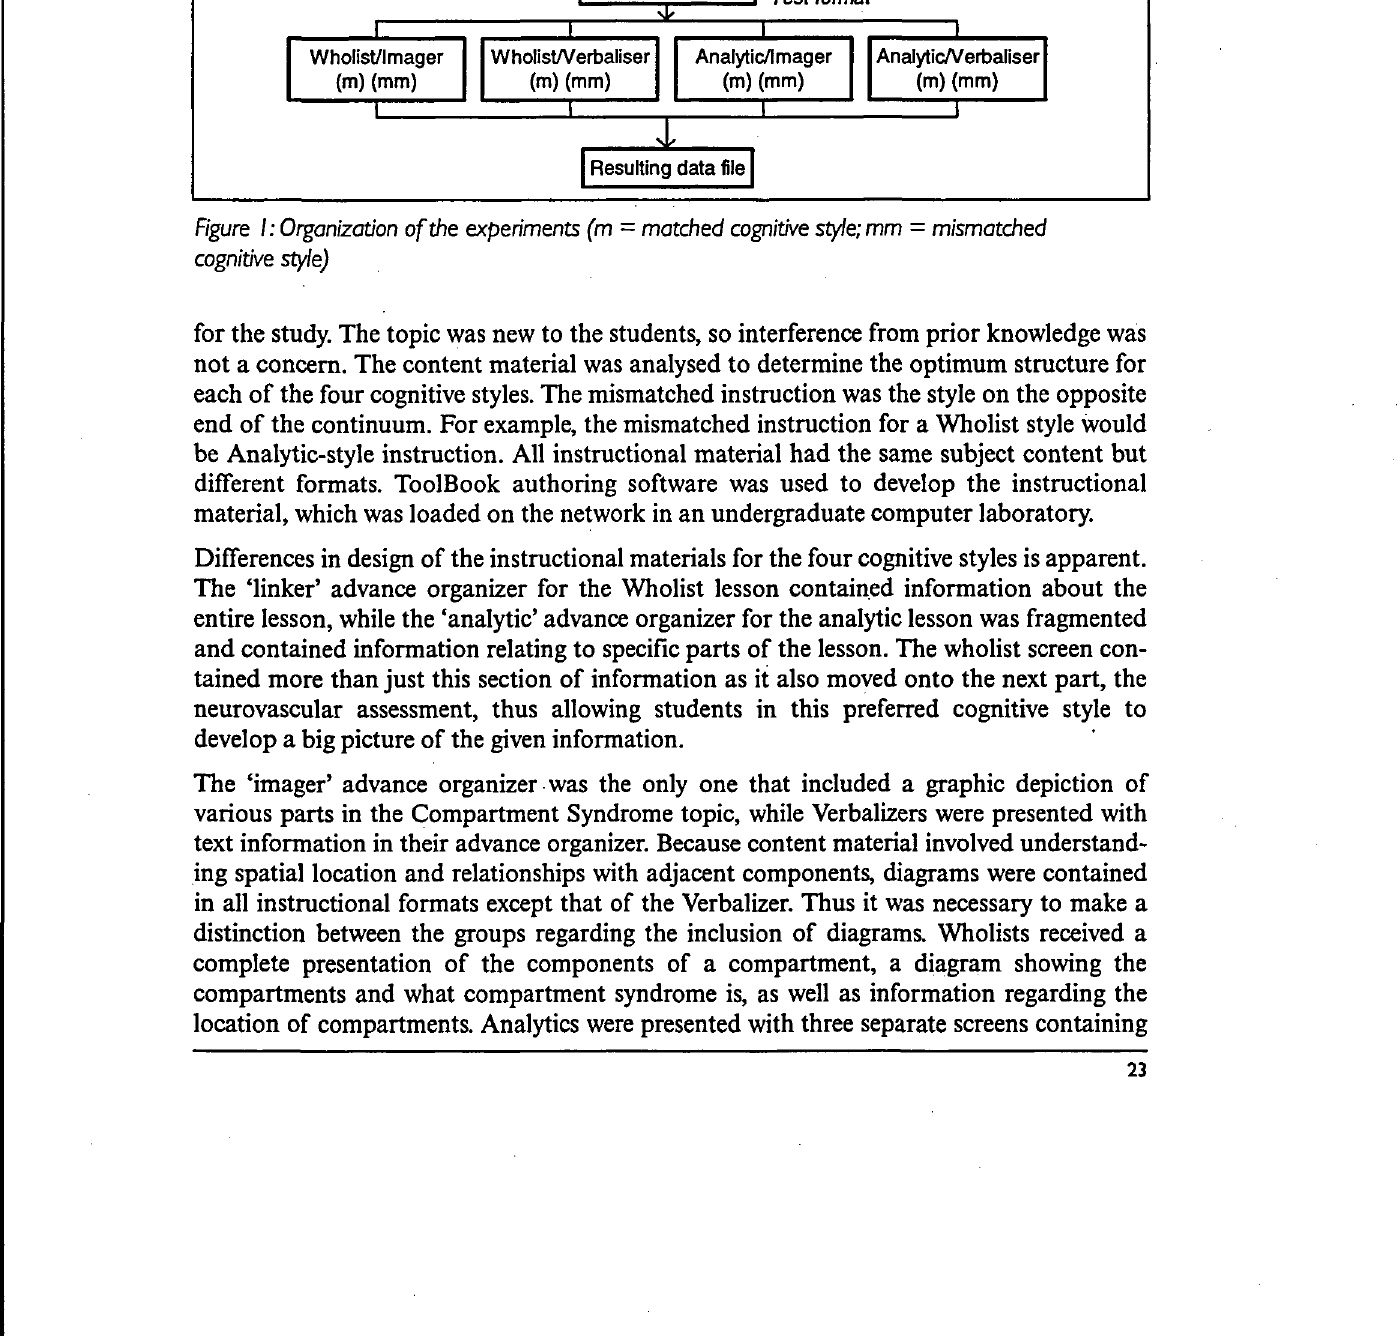
Figure I: Organization of the experiments (m = matched cognitive style; mm = mismatched cognitive